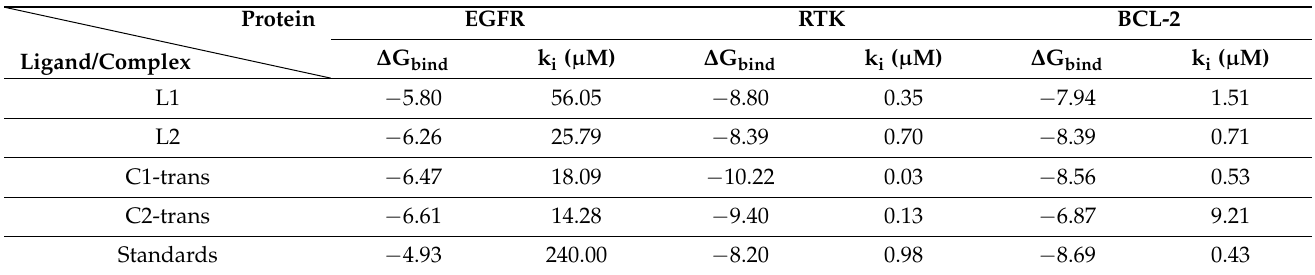
Table 2. Thermodynamic parameters obtained from molecular docking simulation for L1, L2, C1, C2, and standards with EGFR, RTK, and